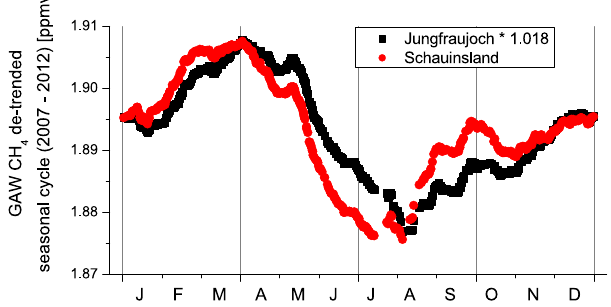
Figure A3. Detrended seasonal cycles observed in the in situ data of Schauinsland and Jungfraujoch. The Jungfraujoch CH 4 mole frac- tion is roughly 2% lower than the Schauinsland mole fraction.